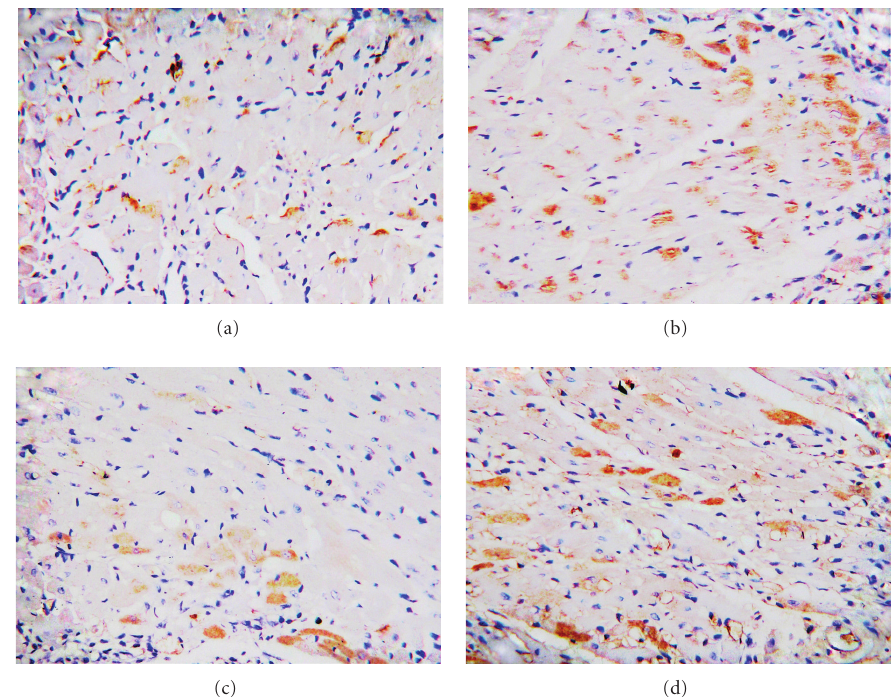
Figure 4: GAP43 immunohistochemicalstainingof the infarct border zone (DAB color, GAP43-positive nerve fibers is orderly. (b) Control ischemic group. GAP43-positive nerve fibers in ventricular muscle increased significantly, it is also thickened and disordered. (c) Preischemic treatment group. (d) Delayed application group. The distribution of GAP43-positive nerve fibers after treatment with desipramine significantly